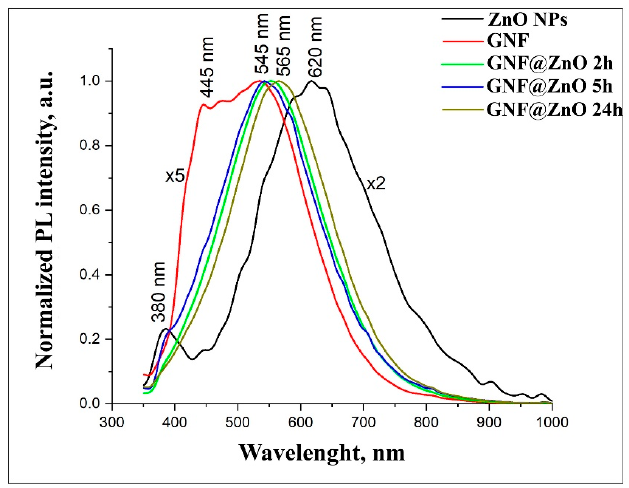
Figure 4. Normalized PL spectra of ZnO, gelatin nanofibers (GNF), and GNF@ZnO composites.